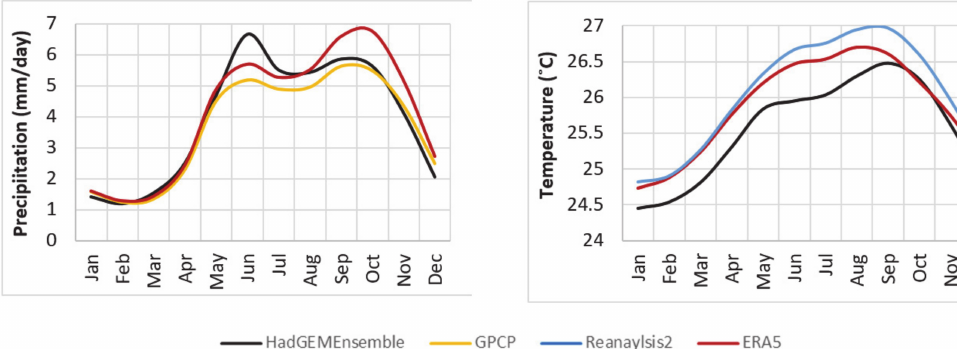
Figure 4. Monthly climatology plots of precipitation ( right ) and air temperature ( left ) for the Caribbean from HadGEM2-ES (black), GPCP (yellow), Reanalysis2 (blue) and ERA 5 (red) datasets. Averaging period is 1985 to